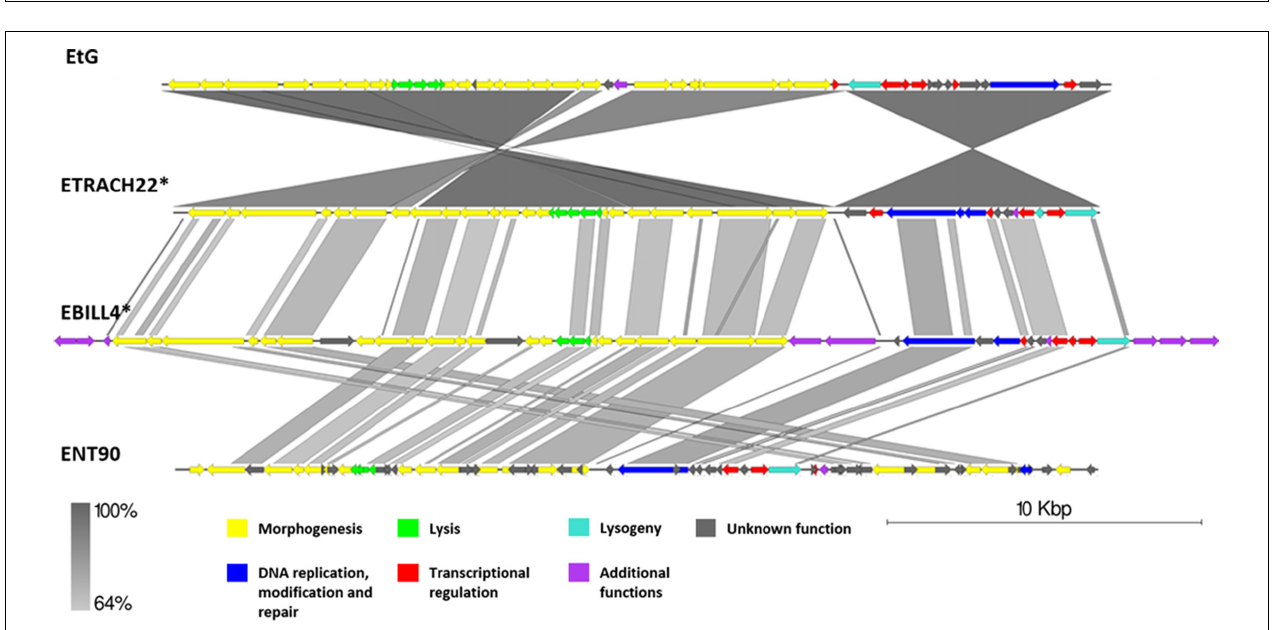
FIGURE 6 | Pairwise genome nucleotide sequence comparison of phages from the suggested cluster 2. Genomes are linearized and drawn to scale; scale bar indicates 10 thousand base pairs. Arrows representing open reading frames point in the direction of transcription and are color-coded according to the legend. Gray boxes between genomes represent regions of similarity and are gradient-colored according to their identity; darker shade of gray represents higher identity. The asterisk next to the phage name indicates a prophage derived from chromosome of Erwinia sp.